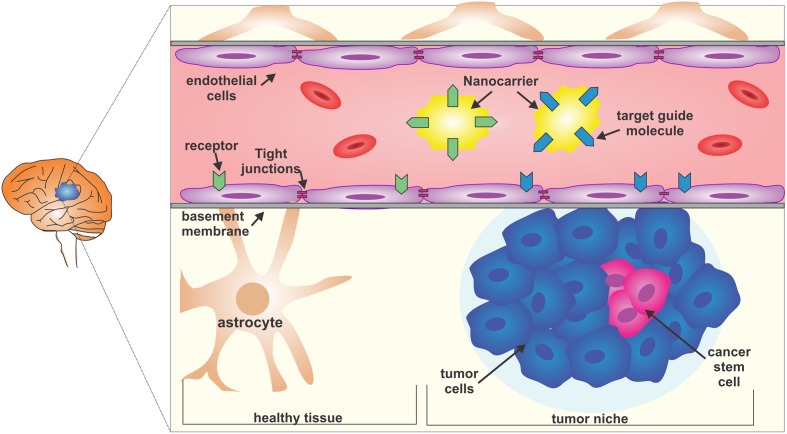
The blood-brain barrier (BBB) and the glioblastoma multiform (GBM) niche. The BBB is selective and restrictive to a variety of molecules. Endothelial cells and the basement membrane, together with strong lateral tight junctions, maintain the selective permeability. A possible strategy to reach the glioma core is to use nanocarriers coupled with target guiding molecules that, for example, bind to the membrane receptors of both tumor niche infiltrated BBB or healthy BBB, and which carry nanomedicines. Glioblastoma is composed of heterogeneous cell populations and the cancer stem cells are responsible for treatment resistance.